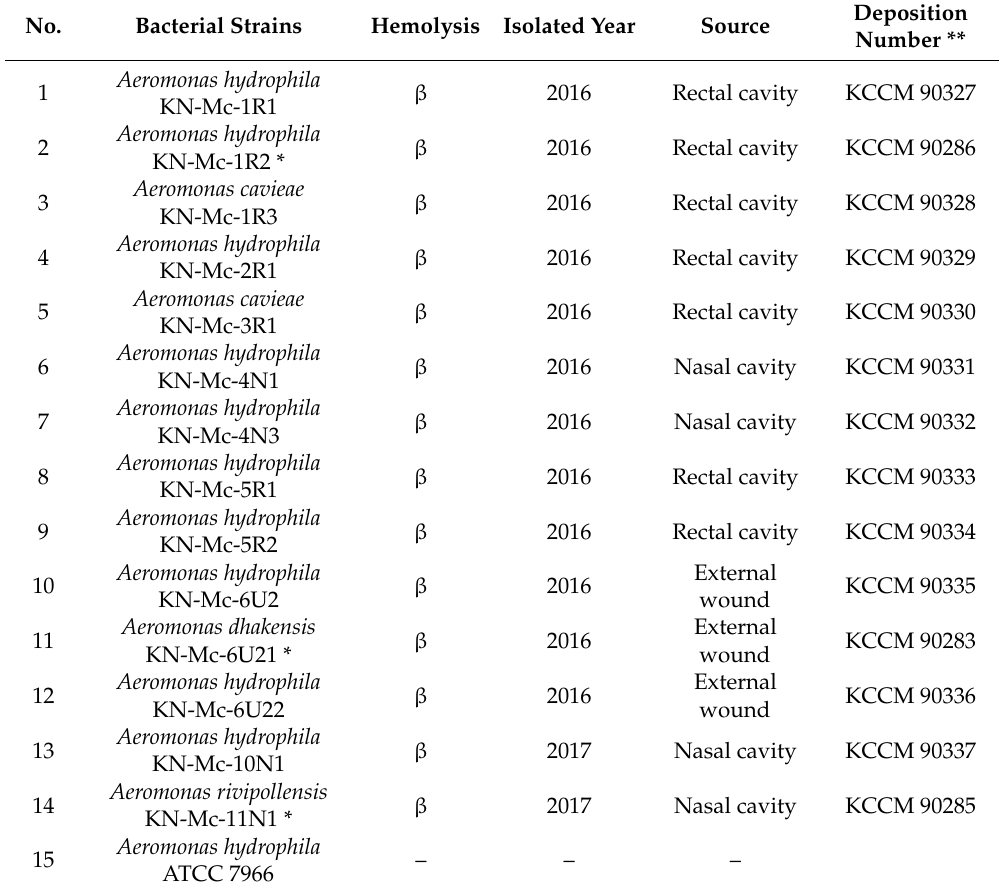
Table 1. Aeromonas isolates identified in this